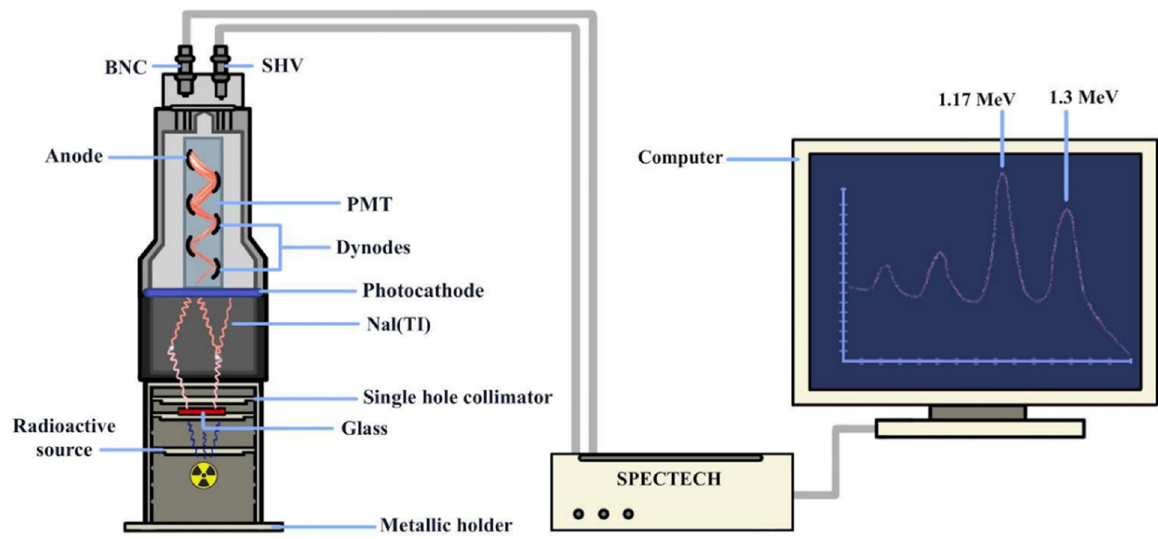
Figure 1. The experimental setup used for measuring the shielding parameters for the proposed sample [10].